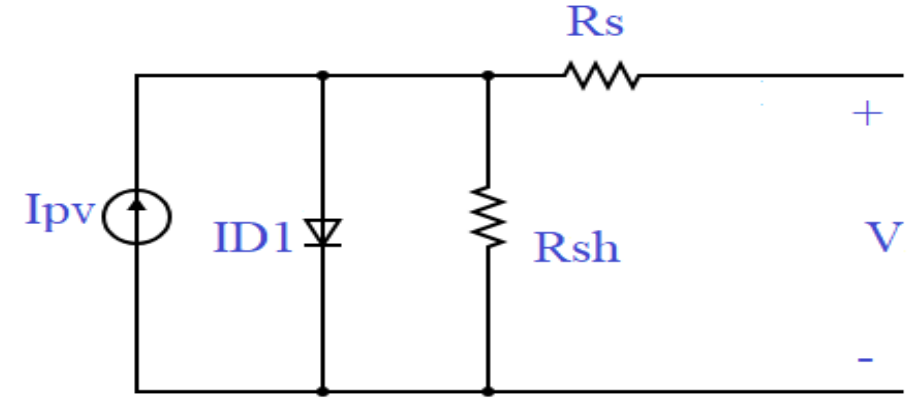
Figure 1. SDMSC circuit.